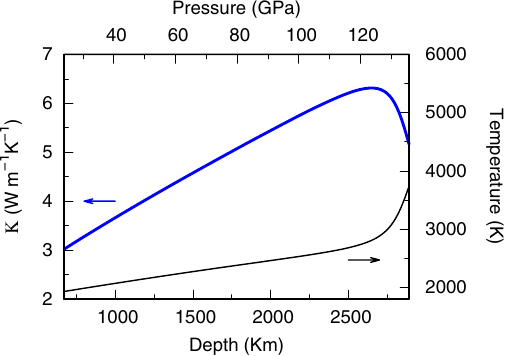
Figure 6. Lattice thermal conductivity of MgSiO 3 pv in the Earth’s lower mantle predicted from standard